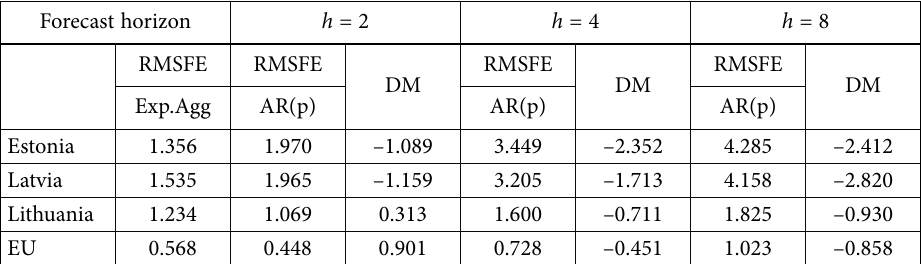
Table 6. Forecast accuracy – Evolved aggregate expectations vs. AR recursive forecasts Forecast